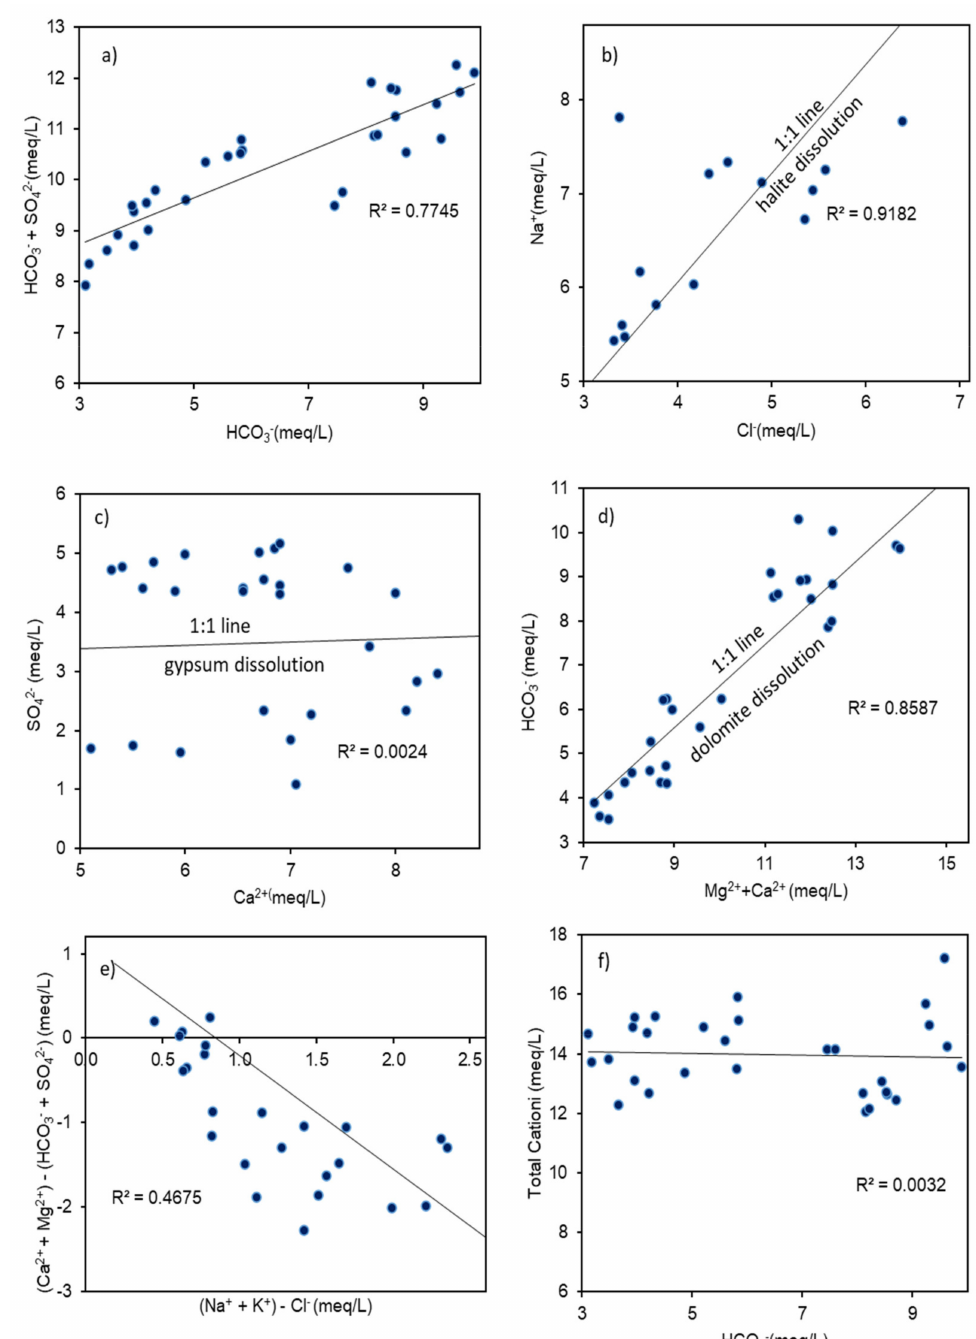
Figure 4. Relationship between major ionic concentrations: ( a ) HCO 3 − +SO 42 − versus HCO 3 − ; ( b ) Cl − versus Na + ; ( c ) Ca 2+ versus SO 42 − ; ( d ) Mg 2+ +Ca 2+ versus HCO 3 − ; ( e ) (Ca 2+ +Mg 2+ ) − (HCO 3 − − SO 42 − ) versus (Na + +K + ) − Cl − ; and ( f ) total cation versus HCO 3 − . The values of the chloro-alkaline indices CAI-1 and CAI-2 had negative values, indi- cating an ion exchange process between Mg 2+ and Ca 2+ ions in water with Na + and K + ions in rocks, thus confirming the tendency towards alkalization of the analyzed groundwater samples (Figure